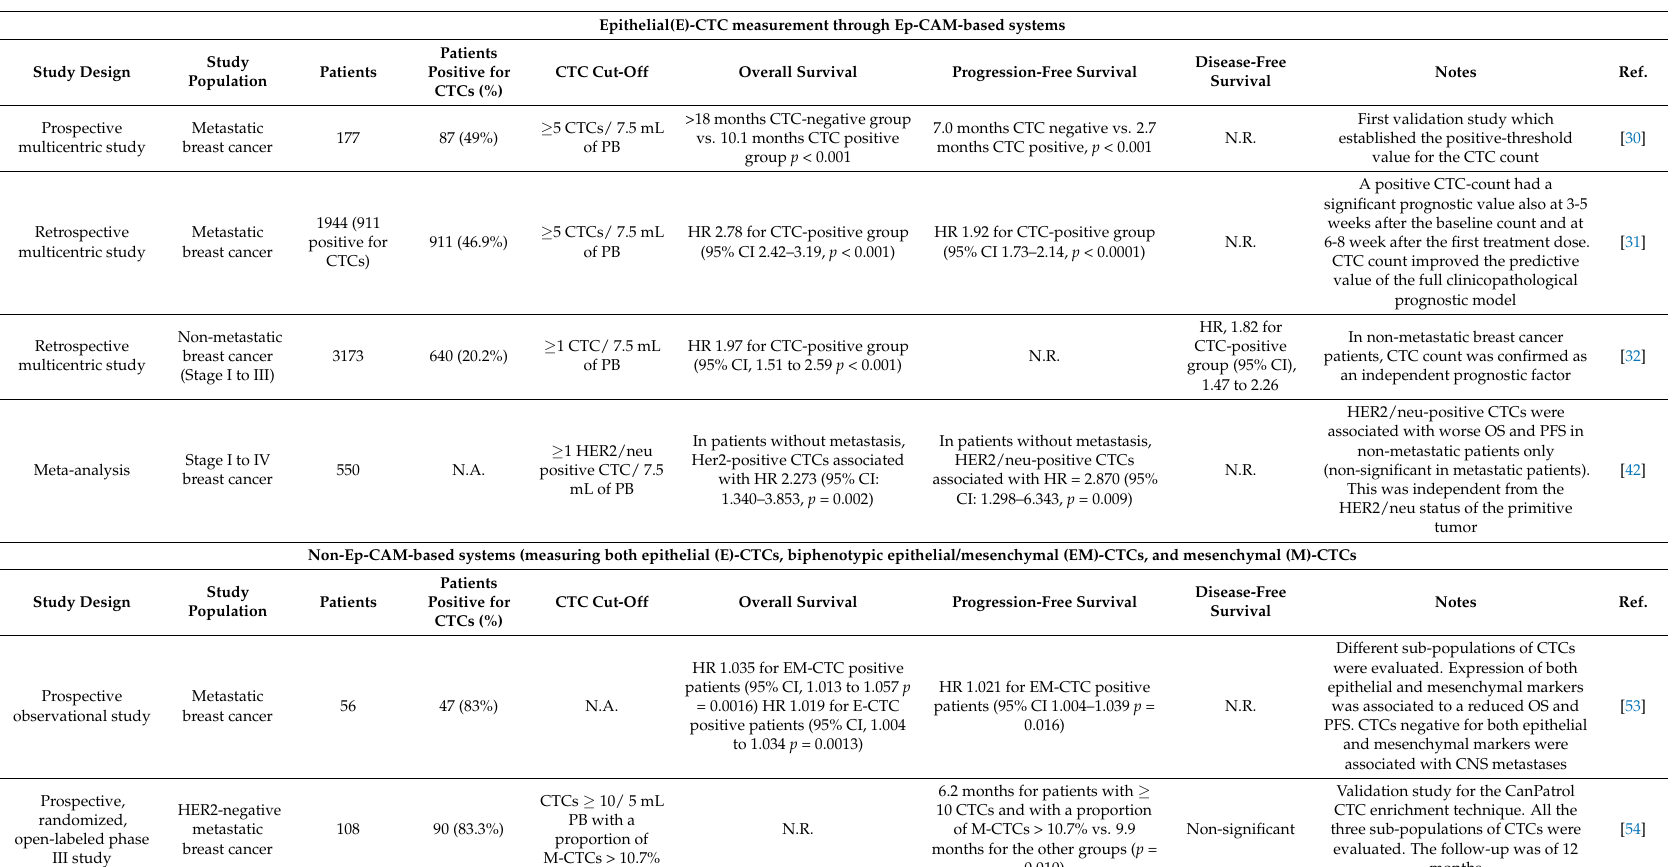
Table 1. CTC-targeting strategies for breast cancer